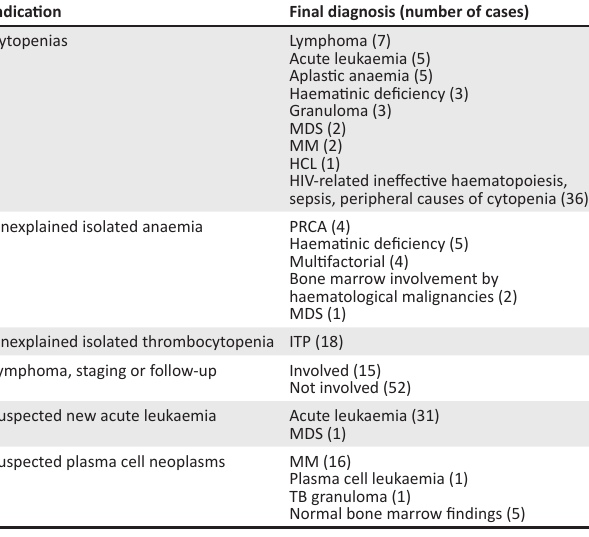
TABLE 3: Diagnostic yield of bone marrow examination by indication. Indication Final diagnosis (number of cases) Cytopenias